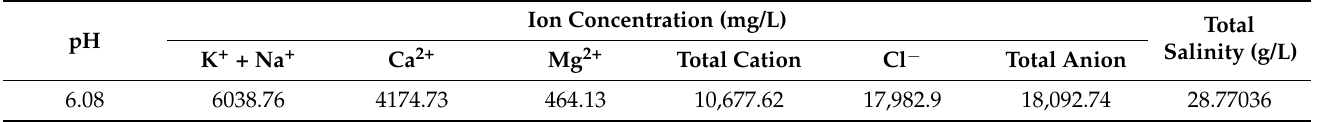
Table 3. The properties of the formation water from Daniudi gas